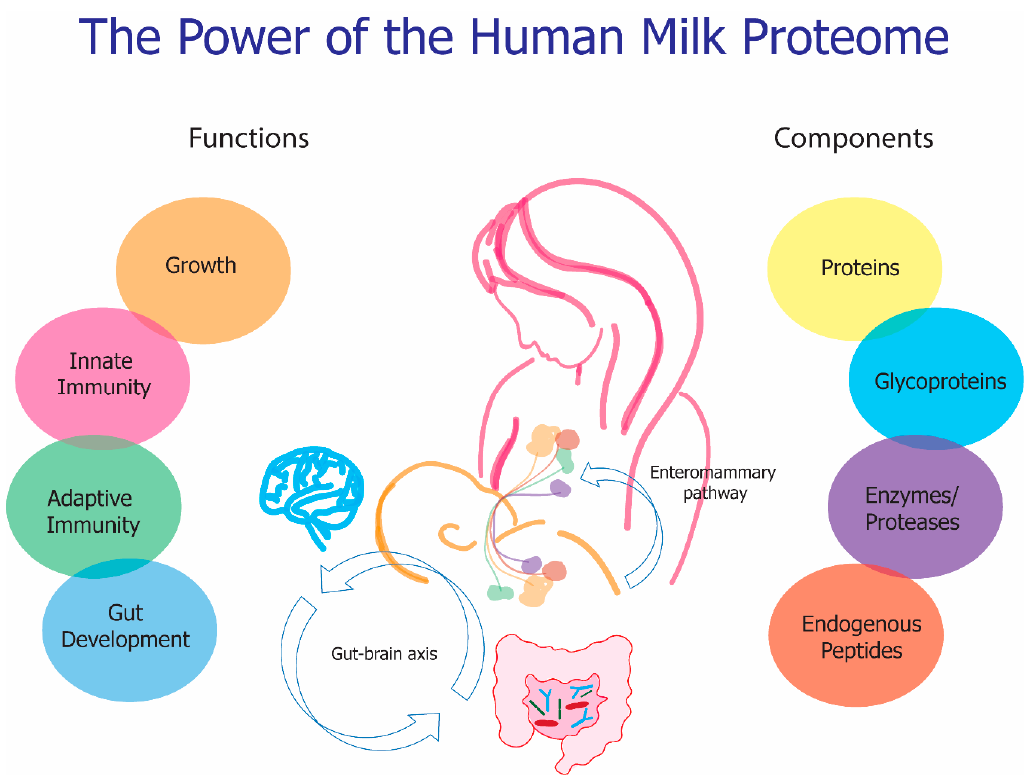
Figure 2. The power of the human milk proteome stems from an evolutionary advantage of cross communication between the mother-infant dyad, via the enteromammary pathway, which in turn stimulated the rise of the uniquely functioning proteome and all of its components. These components work both individually and synergistically to provided protective immunity and overall development to the infant while maintaining health benefits for the mother as well.